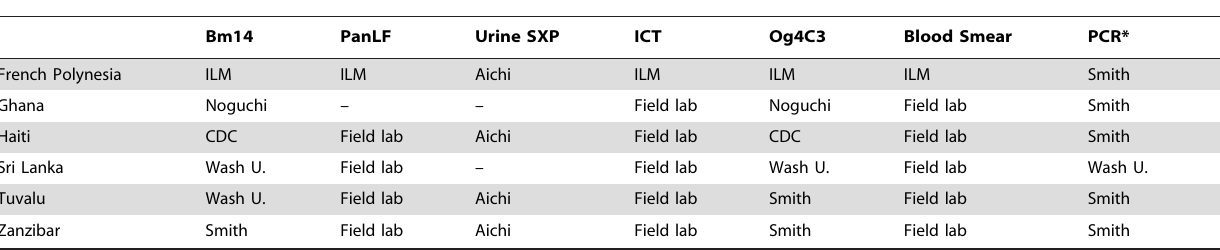
Table 1. Laboratory locations of diagnostic tests.